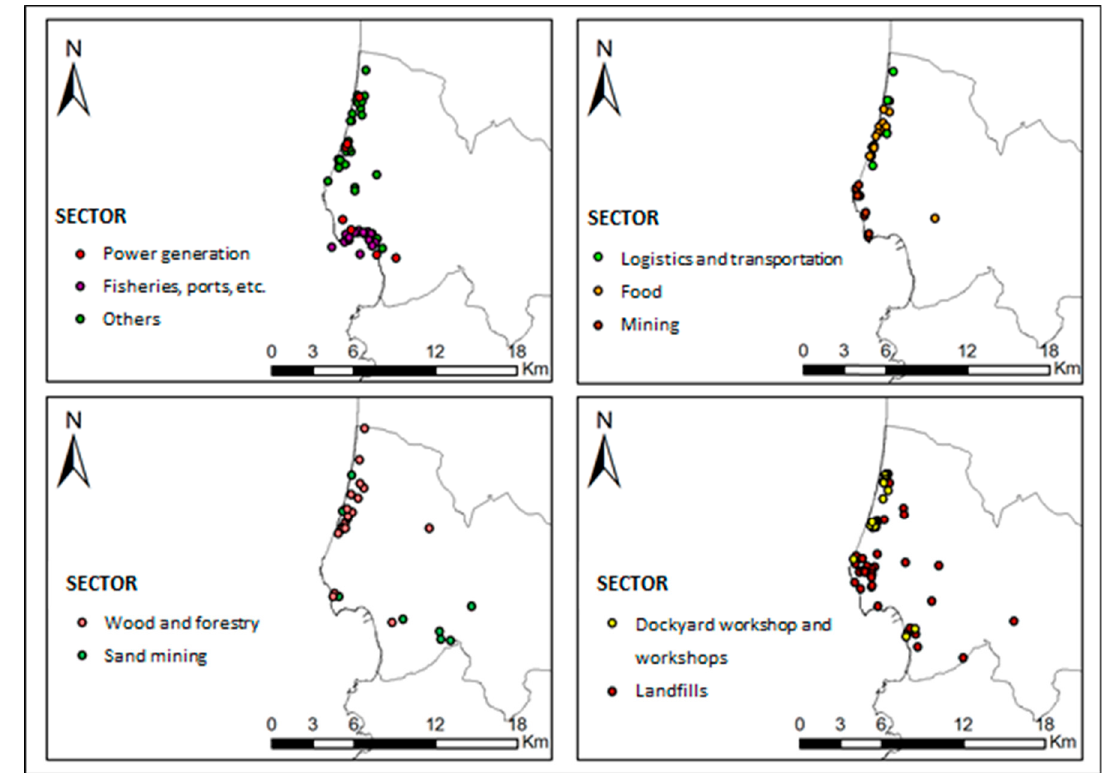
Figure 8. Location of contaminating sources by sector.